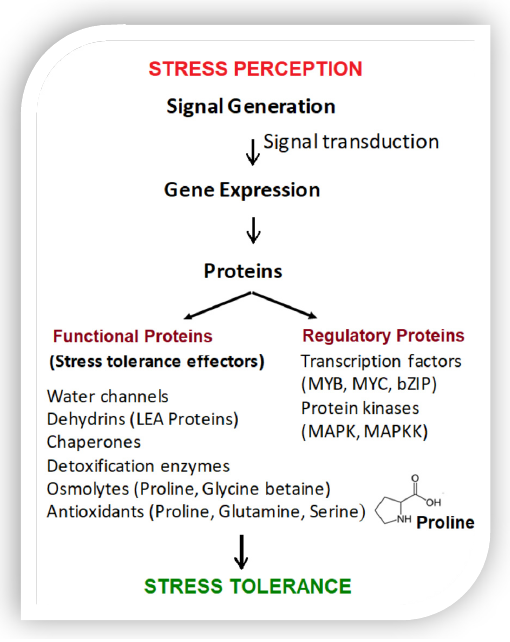
Figure 2. Relationship between stress resistance and proline in plants (data from Beck et al. [8]). Plant-associated microorganisms, such as endophytes, arbuscular mycorrhizal fungi (AMF), and plant growth-promoting (PGP) rhizobacteria, are well-documented for their role in promoting crop productivity and providing stress tolerance [9]. In staple food crops, the symbiotic plant microbiome positively affects plant water and nutrient acquisi- tion, and stimulates flowering and fertility, fruit and grain production. The highest pro- line content across plant developmental stages occurs in plant generative tissues such as flowers, where nectar and pollen are produced in abundance [4]. Several insect species use the proline from plant food as a major energy substrate [10]; they show the ability to oxidize this amino acid at a high rate, which is considered a unique feature of this group of eukaryotes. The presence of proline in the haemolymph of bees and in the nectar of flowering plants led to the hypothesis that plants may produce proline as a metabolic reward for pollinators [11]. It appears that proline serves as metabolic fuel to power pol- linators’ flights. Since honey is a natural food produced by honeybees from the nectar of flowers, it is not surprising that an extensive range in honey proline content ~ 300–900 mg/kg implies different flower origins [12]. Besides that, proline showed properties of a broad-based antioxidant, a trait which has been relatively unexplored in eukaryotic plant, fungi, insects, and mammalian systems [13]. In mammals and fungi, the potential of pro- line may be to suppress reactive oxygen species (ROS) and inhibit ROS-mediated cellular apoptosis [14]. To perform biological functions, the human body can biosynthesize some proline on its own from the amino acid L-glutamate. However, usually, humans and ani- mals, including insects, boost proline levels by obtaining it directly from food sources. 2. Proline: Contradictory Roles in Healing and Excitotoxin Functions Traditionally, the presence of proline was positively correlated with the functionality of the human body by helping form collagen, regenerating cartilage, forming connective tissue, curing skin damage and wounds, healing the gut lining, and repairing joints [15]. However, L-proline has been found to act as a weak agonist or activator of the glycine receptor and of both NMDA and non-NMDA (AMPA/Kainate) ionotropic glutamate